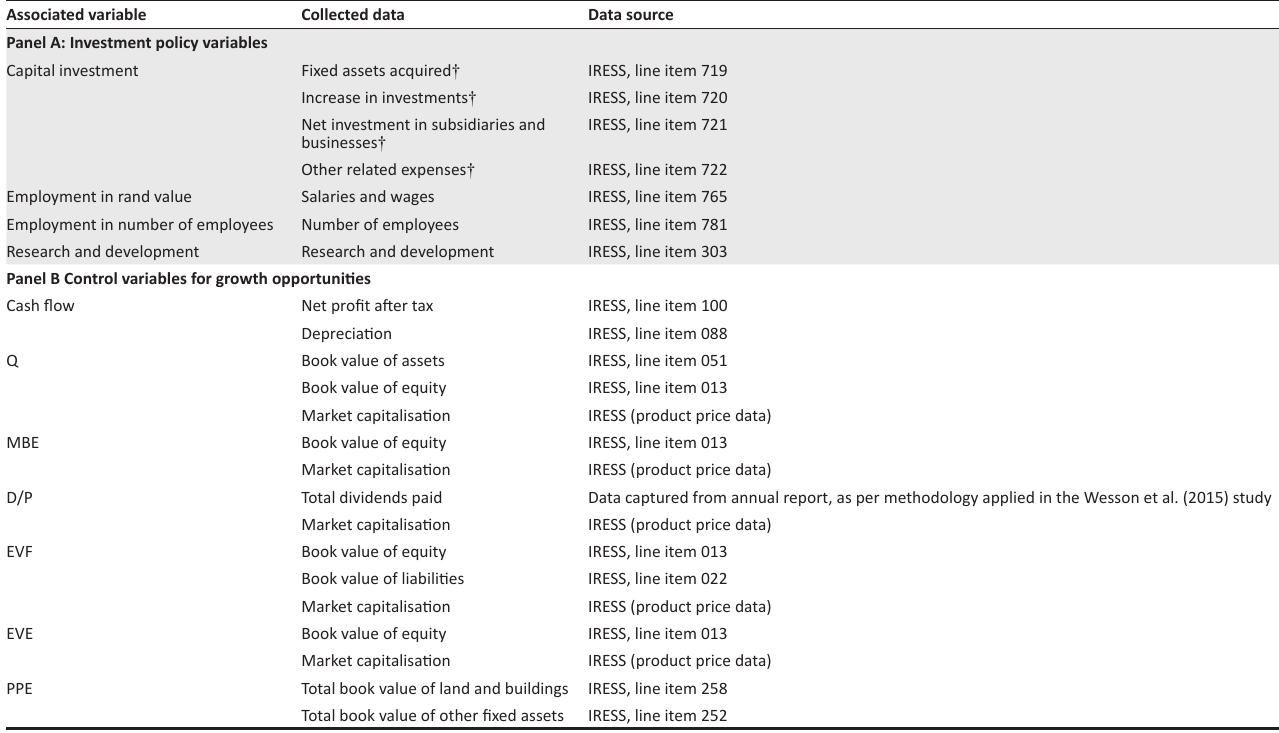
TABLE 1-A1: Summary of data sources of variables.